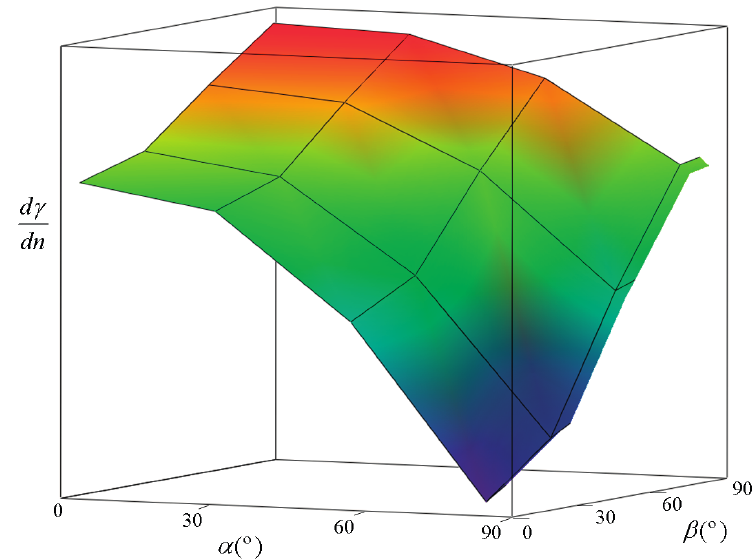
Figure 13. Derivative of γ versus refractive index at different angles of incidence. We can see that the highest value is reached when α is close to 0° and β is close to